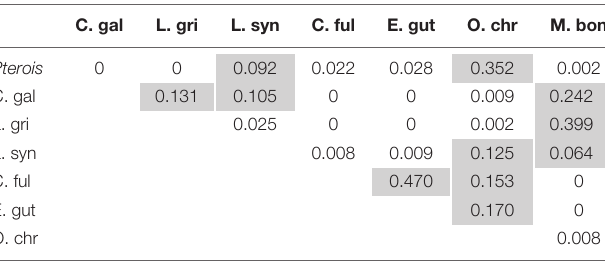
Shaded cells indicate where δ 15 N values were not significantly different (p > 0.05).